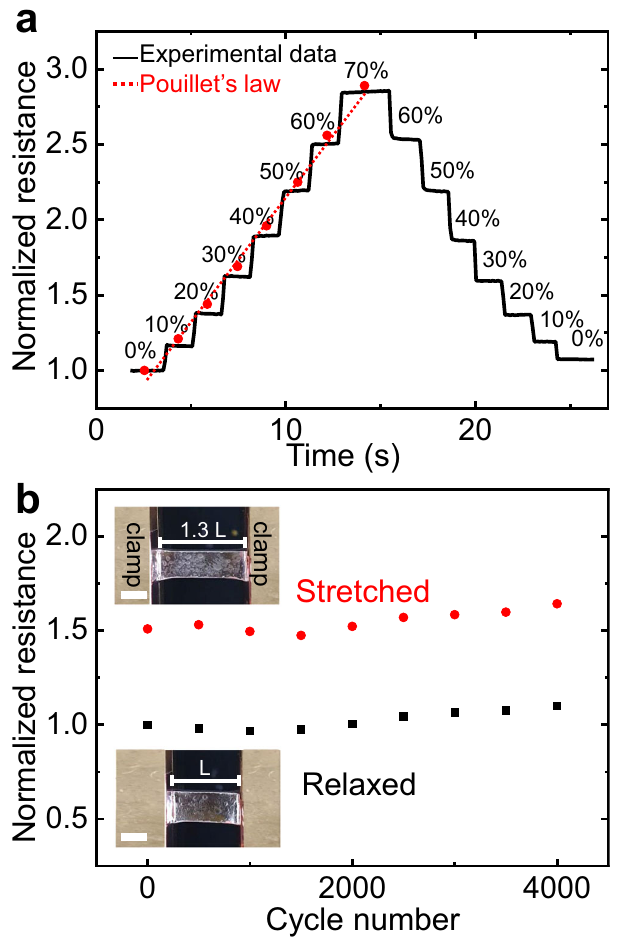
Fig.6|Strain-dependentresistanceofEGaIn/Cu/PDMS.a Normalizedresistance change of EGaIn/Cu/PDMS depending on strain in the range of 0 – 70%. The max- imum strain reached before the PDMS breaks is 70% (Supplementary Fig. 9). The reddotsarethetheoreticalvaluespredictedfromPouillet ’ slaw. b Theconductivity stability test of EGaIn/Cu/PDMS during repetitive stretching – releasing cycles. The cycletestutilized30%strain.Thescalebarsininsetimagesare0.5cm. L istheinitial length of EGaIn/Cu/PDMS before